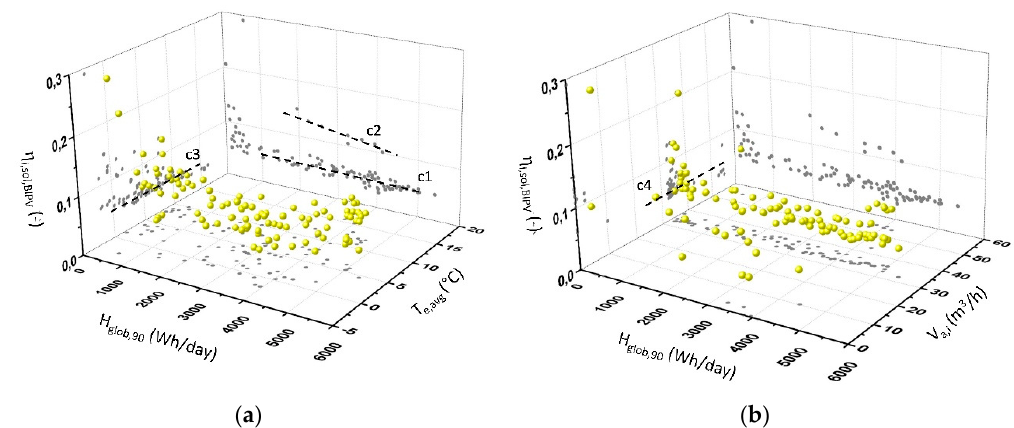
Figure 13. Average daily solar heat gains through composite façade wall behind the glazed BIPV façade structure expressed by efficiency η i,sol,BIPV ; ( a ) impact of the daily solar radiation H glob,90 and average daily outdoor air T e,avg ; ( b ) impact of the solar radiation and ventilation air flow rate , a in V